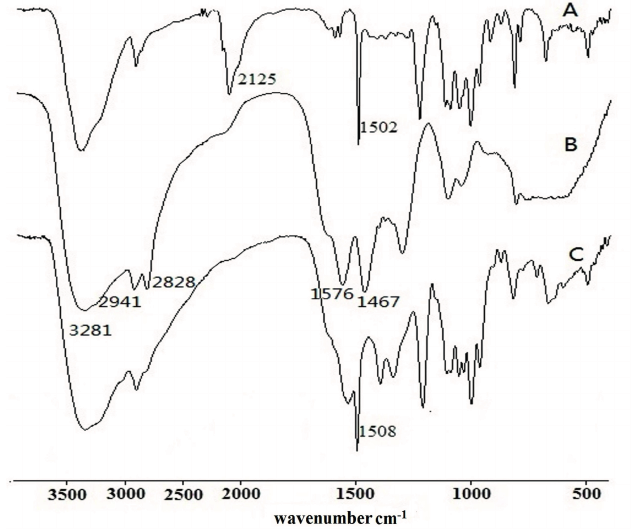
Figure 1. FTIR (Fourier transform infrared spectroscopy) spectra of MPITC ( α - D -mannopyranosylphenyl isothiocyanate) ( A ) PEI 25 ; ( B ) Man-PEI 25k ; ( C ) (KBr